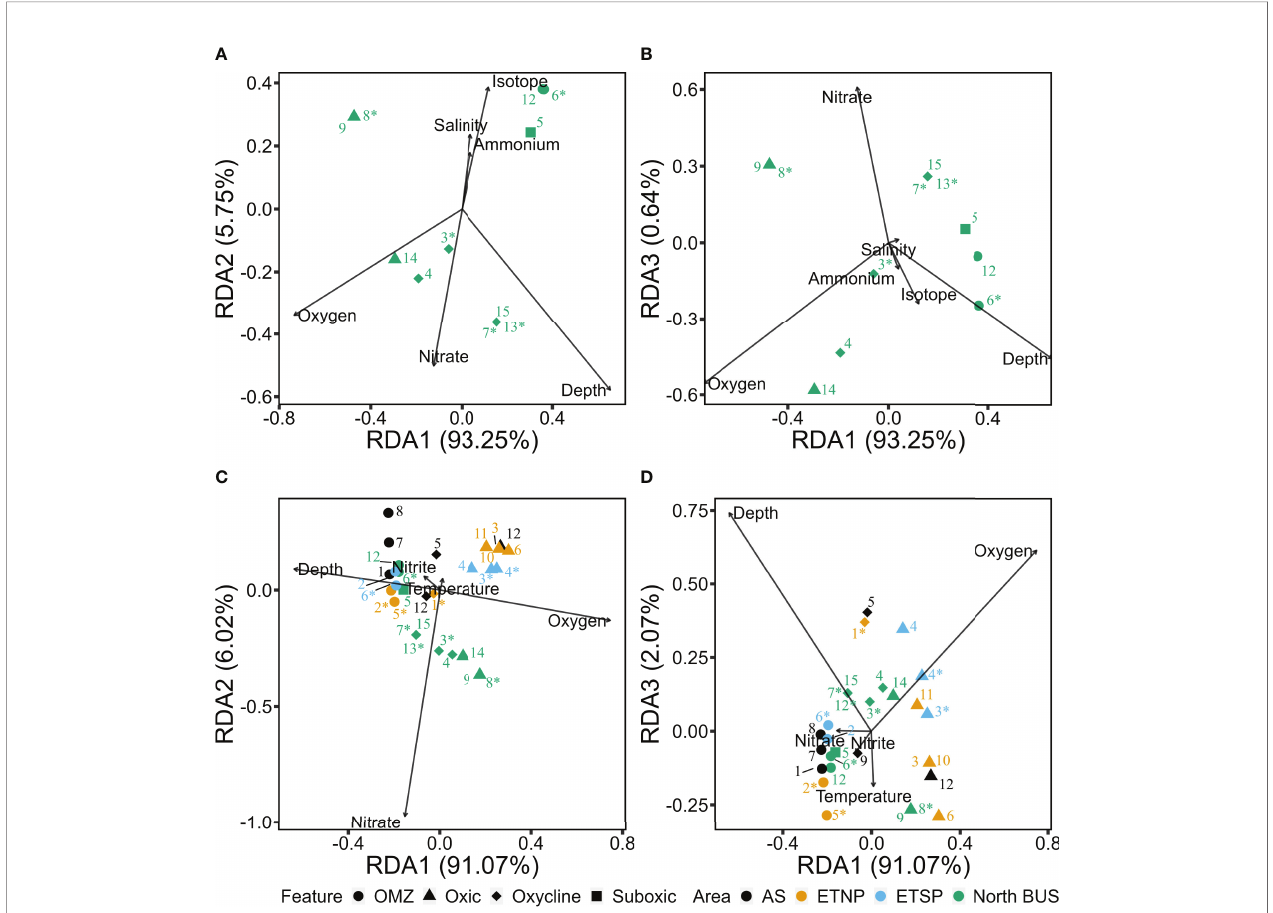
FIGURE 6 | Redundancy analysis (RDA) plot illustrating the relationship between biogeochemical variables and OTUs within the coastal waters the Northern Benguela Upwelling System (North BUS, waters off Namibia) (A, B) and between different OMZ areas (C, D) . Numbers indicate OTU identi fi ers, different shapes denote the O 2 feature. Numbers with * are OTUs belonging to Cluster III, other OTUs belong to Cluster I. The Arabian Sea is denoted in black, the ETNP in yellow, the ETSP in blue and waters off Namibia in green. (A, B) show only the top 15 abundant OTUs derived majorly from Namibia (>5%). (C, D) show OTUs generated from the ETNP, ETSP and AS (Jayakumar and Ward, 2020) along with OTUs from the Northern Benguela Upwelling